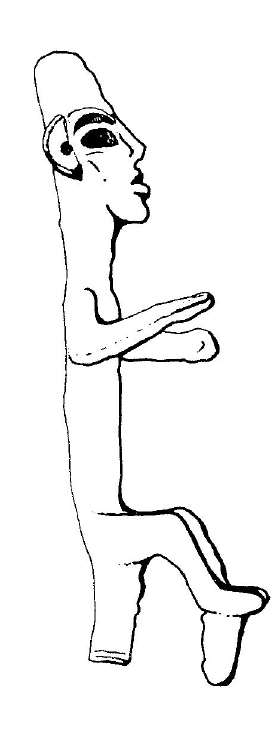
Figure 2 Bronze statue of the El type (Hazor, Iron Age I).